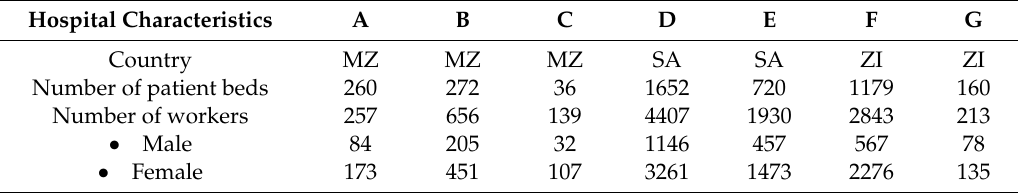
Table 1. Characteristics of the seven hospitals (A–G) participating in the HealthWISE